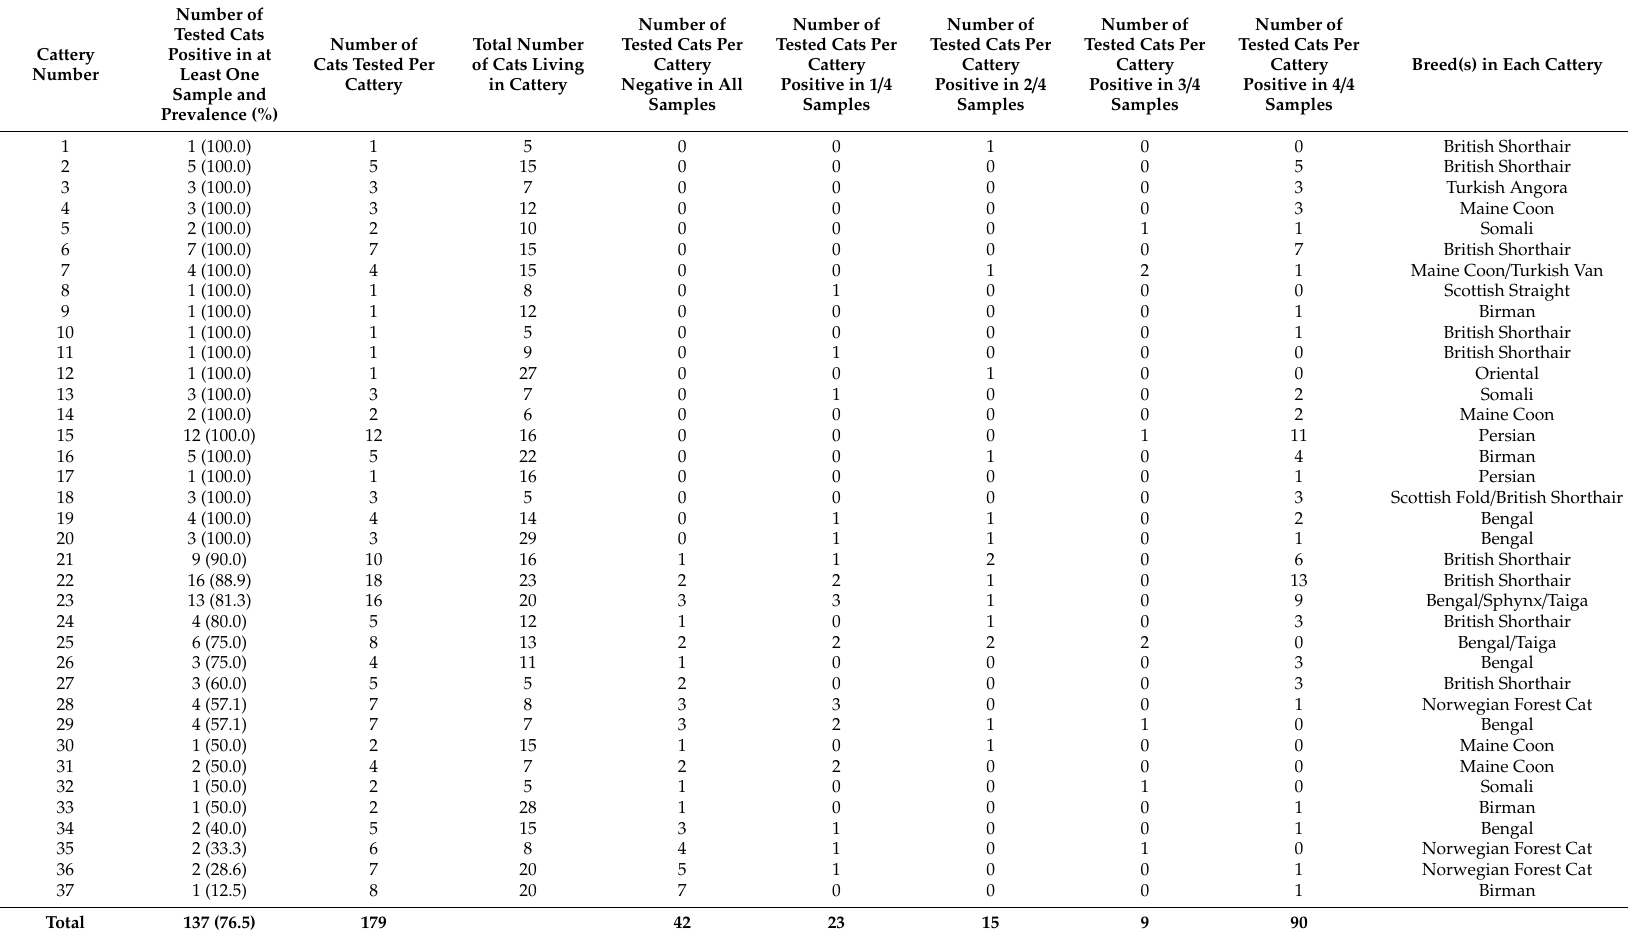
Table 1. Catteries and their prevalence of feline coronavirus (FCoV) shedding: Catteries are ranked in descending order by their prevalence of FCoV shedding. Prevalence was calculated as the number of cats positive for FCoV in at least one of the four samples (positive in 1 / 4, 2 / 4, 3 / 4, or 4 / 4 samples) divided by the number of cats tested. The numbers of cats positive for FCoV in 1 / 4, 2 / 4, 3 / 4, and all four samples are shown for each